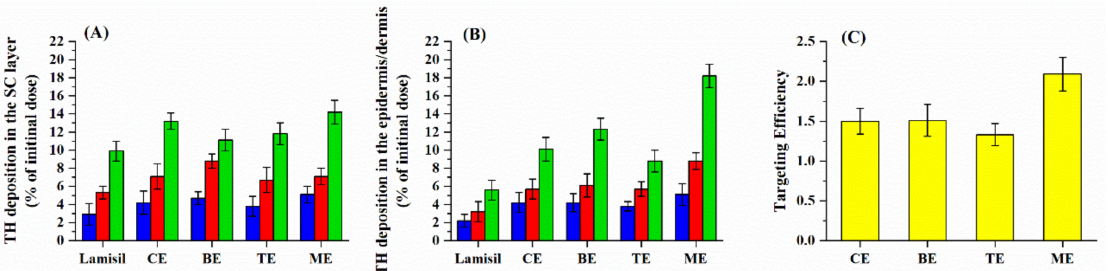
Figure 3. The amount of TH in di ff erent layers of rat skin after deposition at 6 h (blue), 12 h (red), and 24 h (green) ( n = 6). ( A ) TH deposition in the SC layer; ( B ) TH deposition in the epidermis / dermis; ( C ) Targeting e ffi ciency of di ff erent formulations. Data are shown as the mean ± SD ( n =